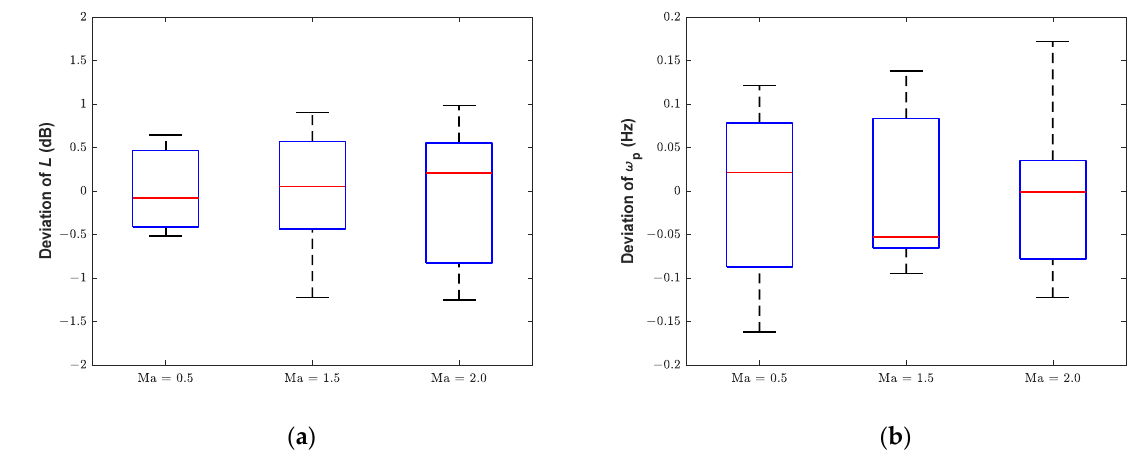
Figure 26. Deviations of gain margin and phase crossover frequency from their mean values at different Mach numbers (U1C1 state). ( a ) Gain margin. ( b ) Phase crossover frequency.